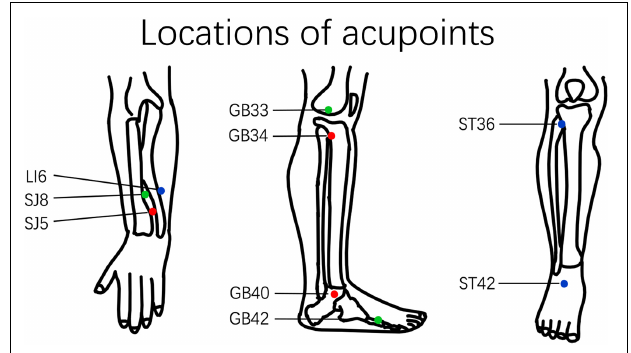
FIGURE 1 | Location of acupuncture points. The different prescriptions for acupuncture points are marked using different colors. GB34, Yanglingquan ; GB40, Qiuxu ; SJ5, Waiguan ; GB33, Xiyangguan ; GB42, Diwuhui ; SJ8, Sanyangluo ; ST36, Zusanli ; ST42, Chongyang ; LI6, Pianli